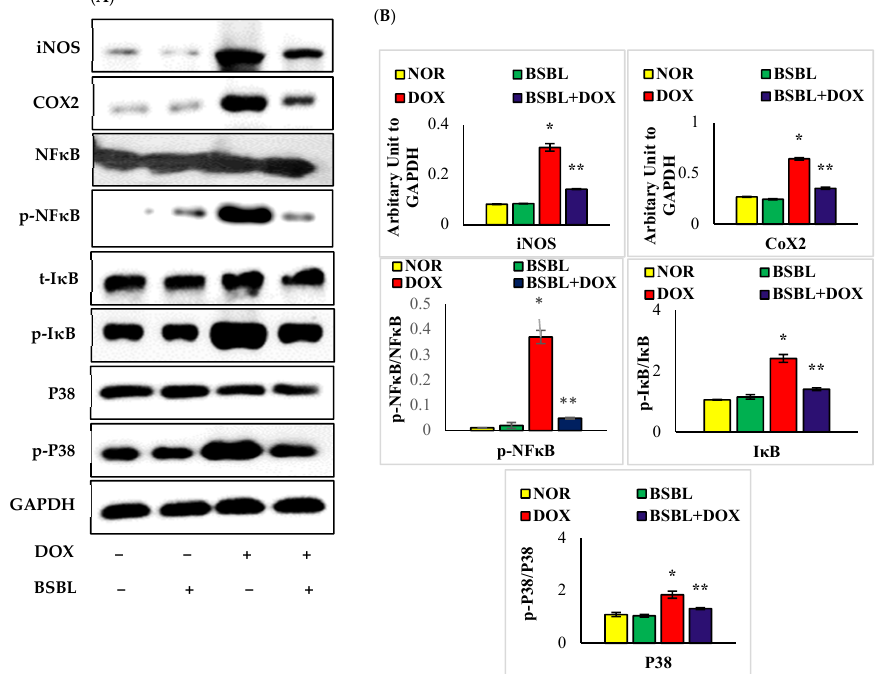
Figure 5. Effect of α -Bisabolol on NF- κ B/MAPK signaling in the kidney of normal and DOX-injected rats. ( A ). Representative images of Western immunoblot analysis for iNOS, COX-2, p-NF- κ B-P65, I κ B α , p-I κ B α , P38, and p-P38. ( B ) Densitometric analysis of renal protein expressions of iNOS, COX- 2, p-NF- κ B-P65, I κ B α , p-I κ B α , P38, and p-P38 assessed by Western blot analysis. The expressions of